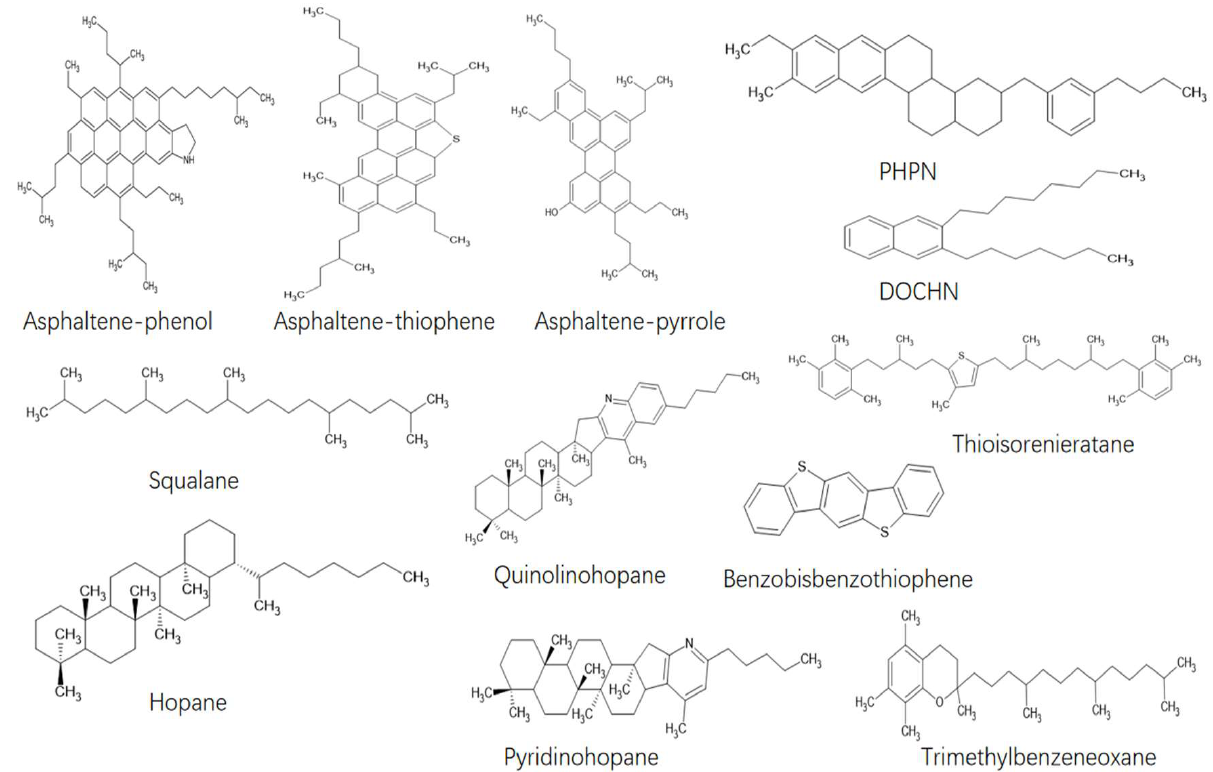
Figure 2. Molecular models of asphalt binder.